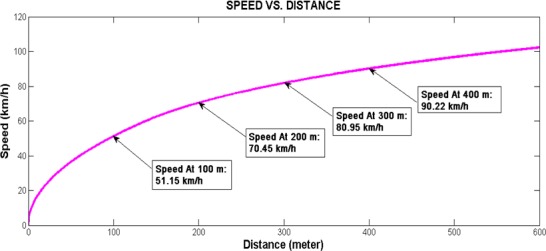
Speed versus distance plot.